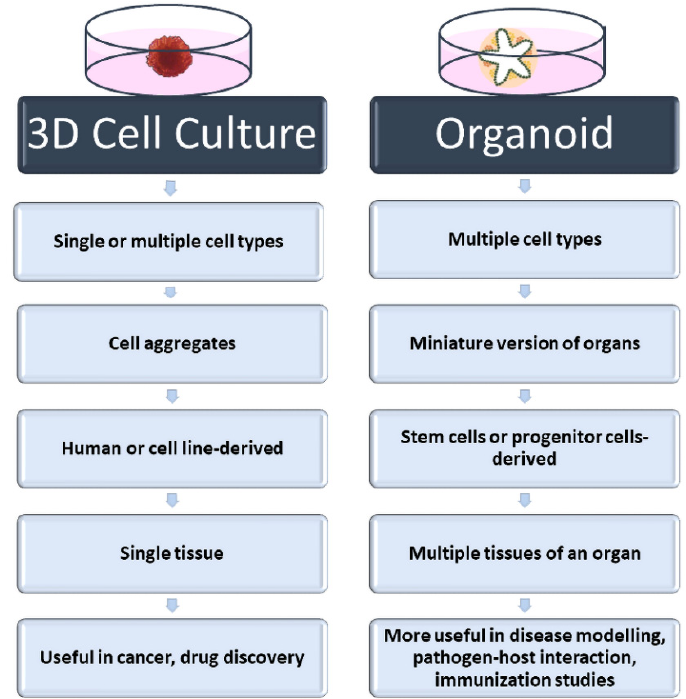
Figure 2. Main characteristics of spheroids, and organoids .